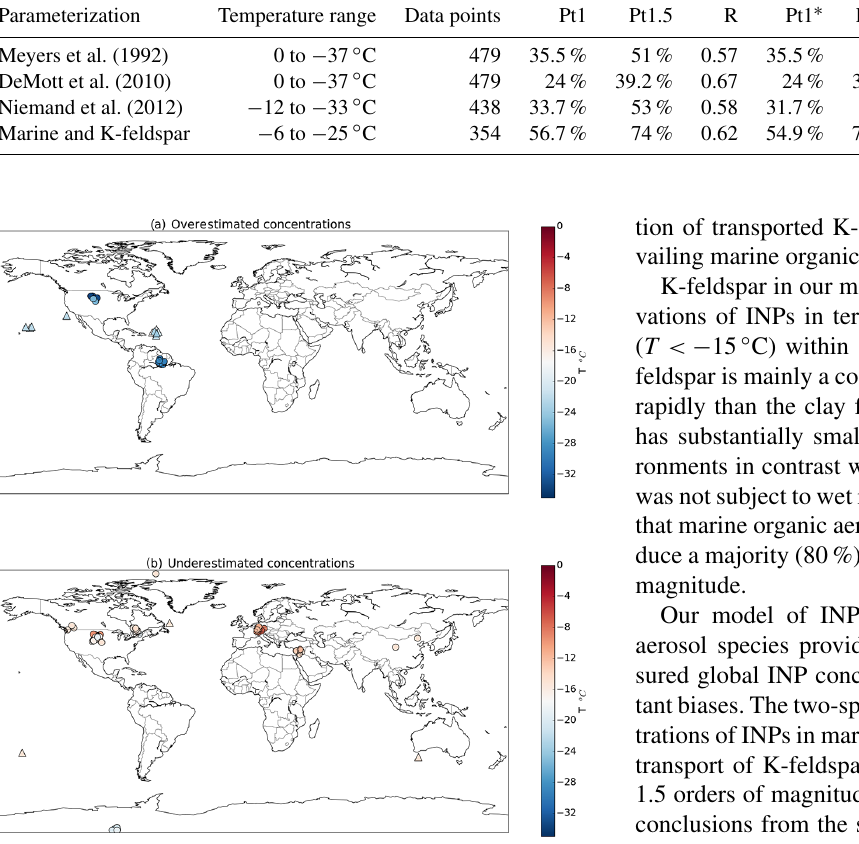
Figure 10. Overestimation and underestimation of places according to our two-species-based parameterization of INP (Atkinson et al., 2013; Wilson et al., 2015). (a) Shows the places where we overes- timate the values of INPs by more than 1.5 orders of